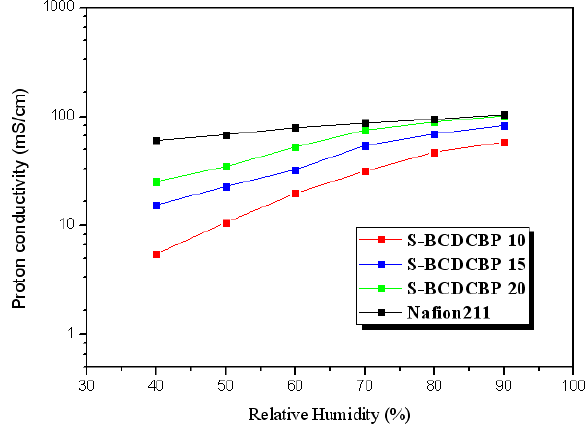
Figure 4. Proton conductivity of SBCDCBP membranes and Nafion 211 ® at 80 °C and varying relative humidity (RH).